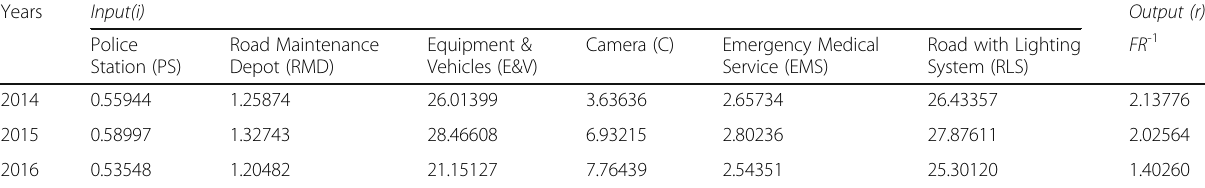
Table 11 Data analysis. The existing dataset for Qom province Years